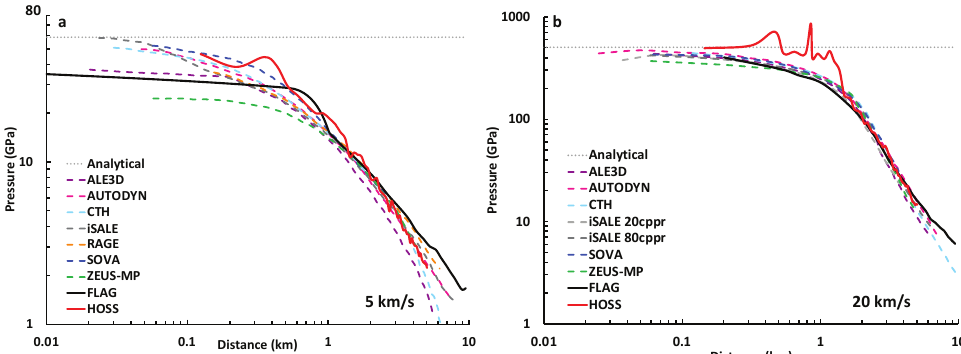
Figure 9. 3D normal impact, vertical tracers from FLAG and HOSS simulations, plotted with data from Pierazzo et al. [5] for ( a ) 5 km/s impact and ( b ) 20 km/s